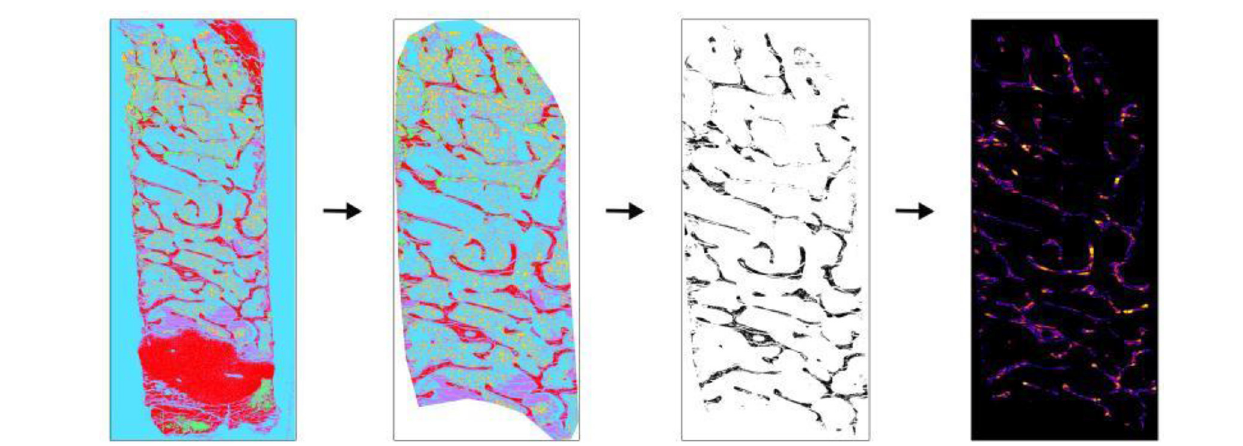
FIGURE 3 | Application of BoneJ in the measurement of Tb.Th and Tb.Sp. Movat pentachrome stain classified overview of sheep iliac crest biopsy was used to obtain Tb.Th and Tb.Sp. (Left to right). The classified overview was uploaded and scale was set. The cortical bone and cartilage area was cleaned out to measure trabecular parameters. The image was then converted into binary using ImageJ toolbox. Trabecular bone appears as black and other as white. “Thickness” option present in BoneJ drop-down menu was selected and output graphical overview along with measured values were obtained.